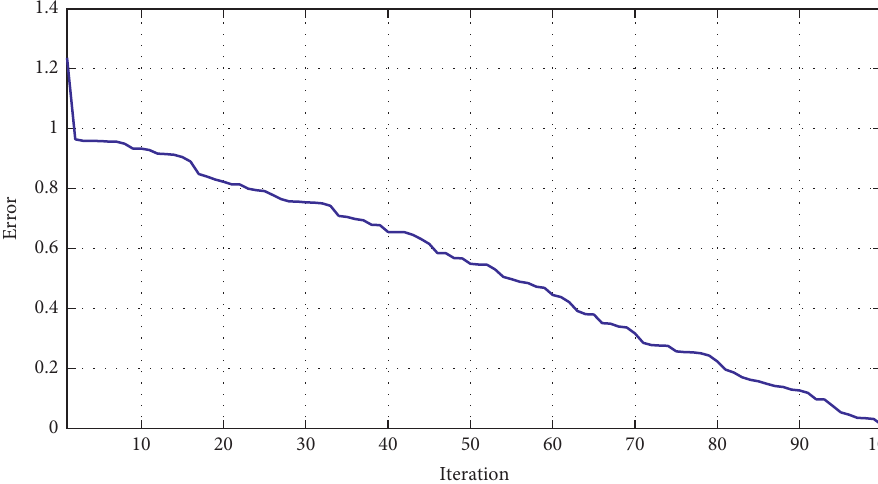
Figure 8: Error in each training